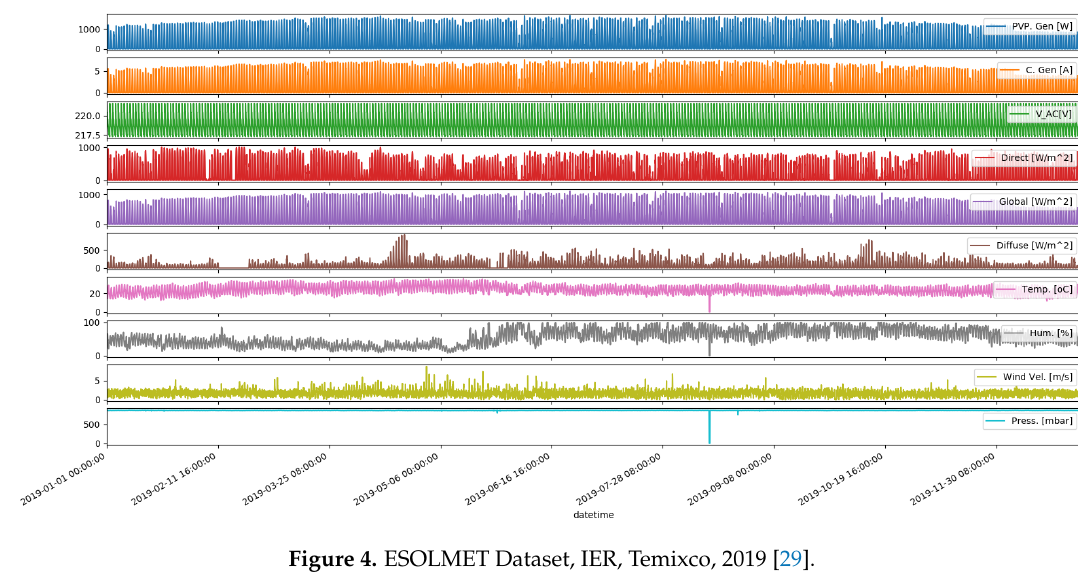
Figure 3. Distance between ESOLMET and the PVSS in Temixco, Morelos.